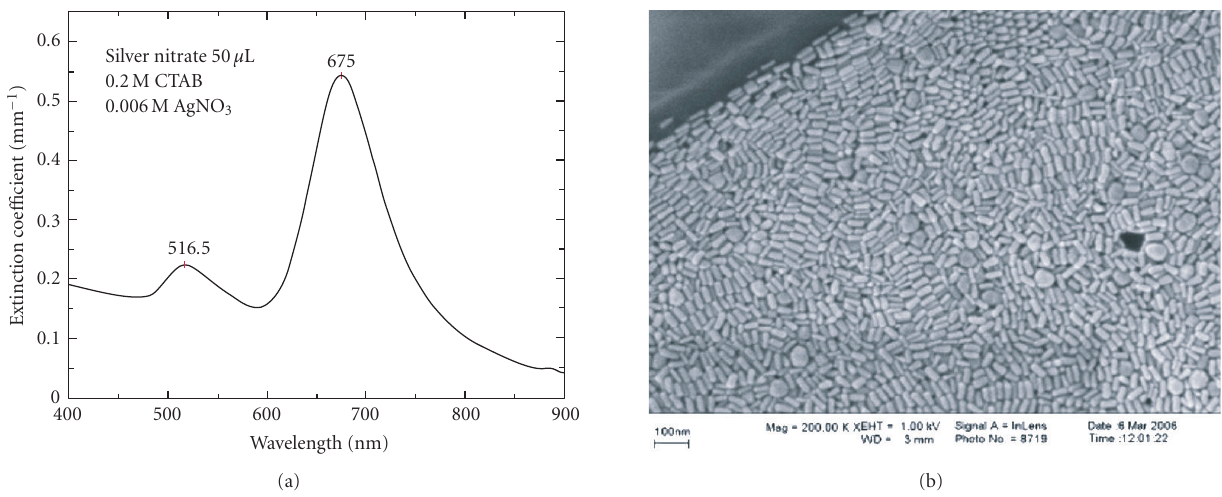
Figure 2: Gold nanorods synthesized using 50 μ L of silver nitrate in growth solution. (a) Optical extinction spectrum showing the transverse plasmon peak at 516.5 nm and the longitudinal plasmon peak at 675 nm. The amplitude of the longitudinal plasmon peak is higher than transverse plasmon peak which indicates the formation of high yield of nanorods compared to spheres. (b) High-resolution scanning electron microscope (SEM) image of gold nanorods showing high monodispersity. Few nanospheres are observed.